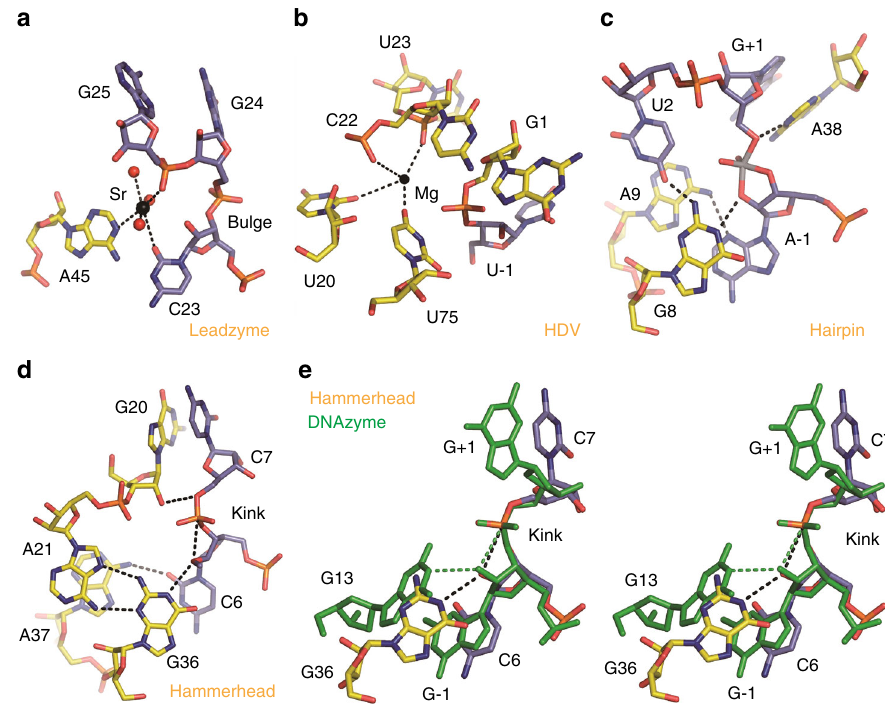
Fig. 6 Comparison of the catalytic site architectures between 8 – 17 DNAzyme and RNA-cleaving ribozymes. The catalytic site architectures observed in the a leadzyme (PDB_ID:1NUV), b HDV (PDB_ID:1JS3), c hairpin (PDB_ID: 1M5O), and d hammerhead (PDB_ID: 3ZP8) ribozymes. e Superposition of the catalytic site residues in the hammerhead ribozyme and 8 – 17 DNAzyme structures. 8 – 17 DNAzyme structure is colored in green in e . In a – e , the C-atoms are colored in yellow and light blue for ribozymes and substrates, respectively, whereas other atoms are colored with the same scheme (N, blue; O, red; P, orange) for both ribozymes and substrates. Sr 2+ ion, water molecules, and Mg 2+ ion captured in the leadzyme and HDV ribozyme structures are shown as spheres in black, red, and black,